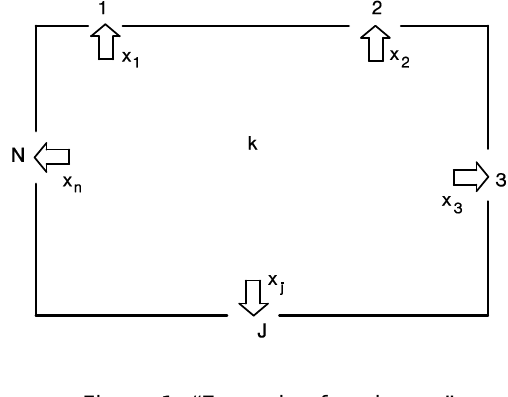
Figure 1. “Example of